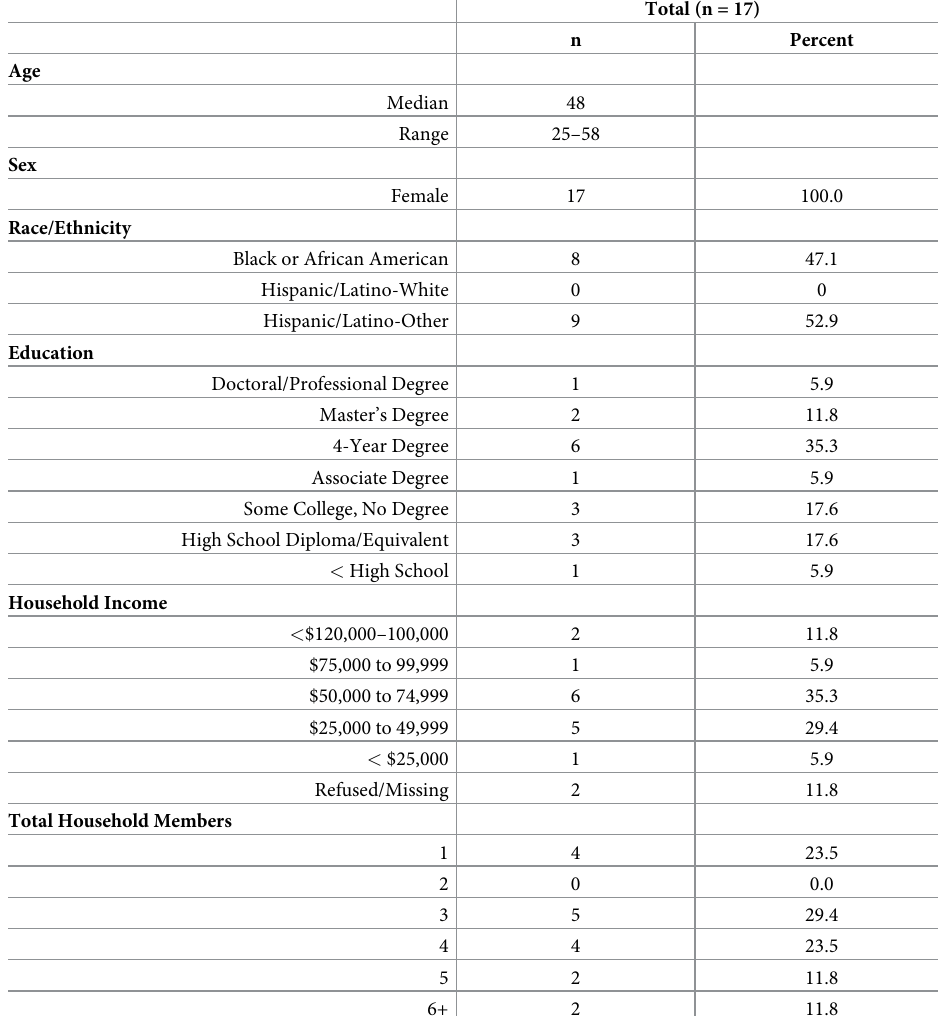
Table 1. Demographic characteristics of study